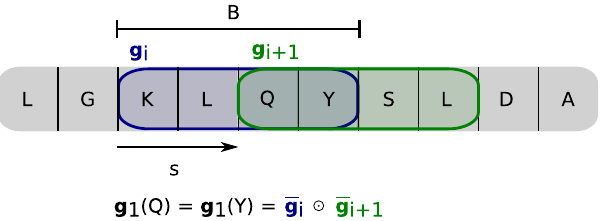
Fig. 6 | Attention scheme for amino acid chain. Windows of size B are placed along the chain with a step size of s resulting into W many windows. A trainable weight g 2 R W × N is assigned for a window in each subsystem which are made positive and normalized along the window axis through a softmax (cid:2) g =softmax ð g ,dim =0 Þ . Here a window size of B =4 and a step size of s =2 is chosen.Asaconsequencetheweightoftheaminoacidglutamine(Q)isgivenasthe product of the two windows it is part of g 1 ð Q Þ = (cid:2) g i (cid:3) (cid:2) g i +1 , where the multiplication is executed element wise for each subsystem. The choice of the step size deter- mines how many neighboring amino acids have the exact same weight within a subsystem,whichapplieshereforthetyrosine(Y).Togetherwiththewindowsizeit is regulated how many residues share parts of their weights. Hence, the serine (S) sharestheweight (cid:2) g i +1 withtheprevioustwoaminoacids g 1 ð S Þ = (cid:2) g i +1 (cid:2) g i +2 ,whichhas a smoothing effect on the attention mechanism along the